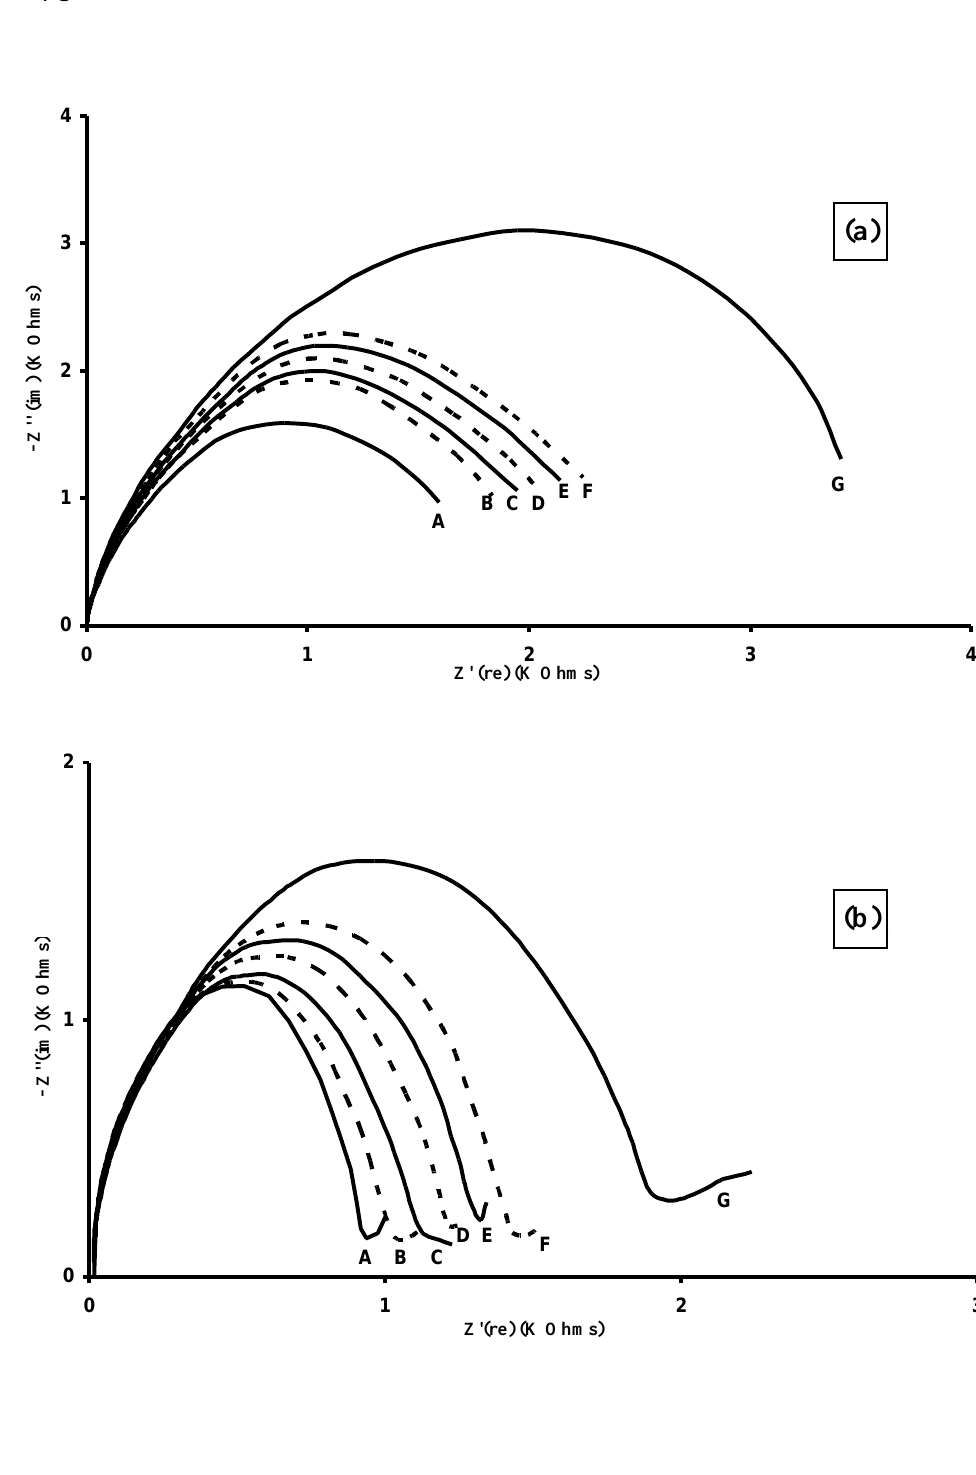
Figure 22. Specific binding of PSA for (a) entrapped APSA, Nyquist plot, concentrations of PSA (A) 0; (B) 1; (C) 2; (D) 3; (E) 4; (F) 5 and (G) 10 ng mL –1 ; (b) affinity immobilised APSA, Nyquist plot, concentrations of PSA (A) 0; (B) 1; (C) 2; (D) 3; (E) 4; (F) 5 and (G) 10 pg mL –1